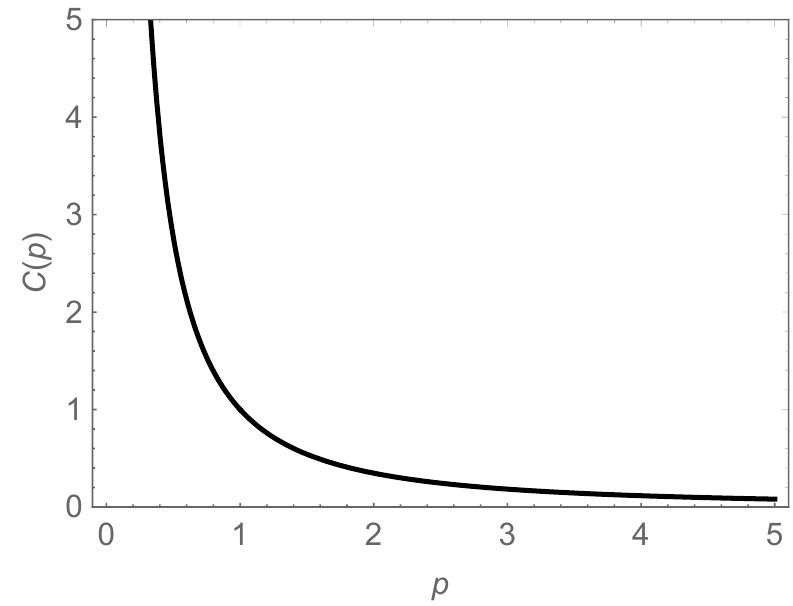
Figure 7. Curves of C ( p ) versus p on the interval 0 < p ≤